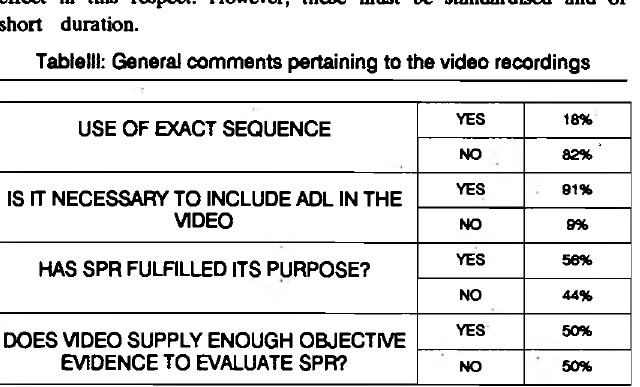
Tablelll: General comments pertaining to the video recordings